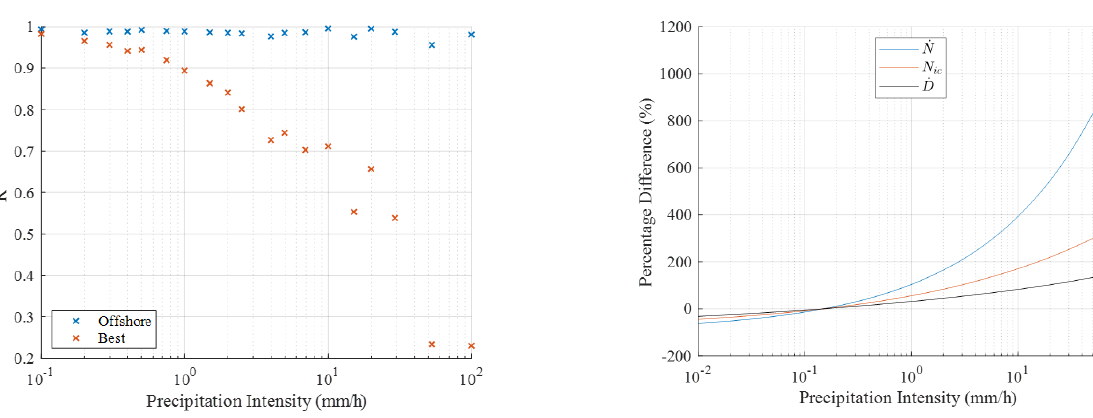
Figure 11. Coefficient of determination of the offshore DSD and the Best DSD across a range of precipitation intensities.